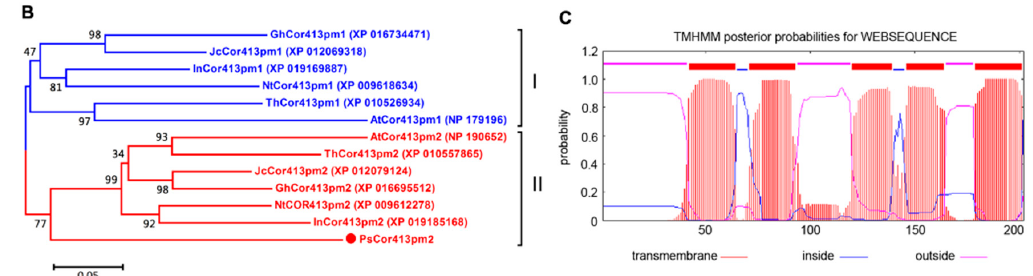
Figure 1. Sequence analysis of PsCor413pm2. Amino acid sequence alignment ( A ) and phylogenetic tree ( B ) of PsCor413pm2 with Cor413pm proteins from Arabidopsis thaliana (GenBank accession numbers: NP_179196 and NP_190652), Nicotiana tomentosiformis (XP_009618634 and XP_009612278), Ipomoea nil (XP_019169887 and XP_019185168), Tarenaya hassleriana (XP_010526934 and XP_010557865), Jatropha curcas (XP_012069318 and XP_012079124), and Gossypium hirsutum (XP_016734471 and XP_016695512) are shown. Colored backgrounds indicate identical residues. The black box bars indicate five putative transmembrane (TM) domains. ( C ) Putative transmembrane domains of PsCor413pm2 are shown.